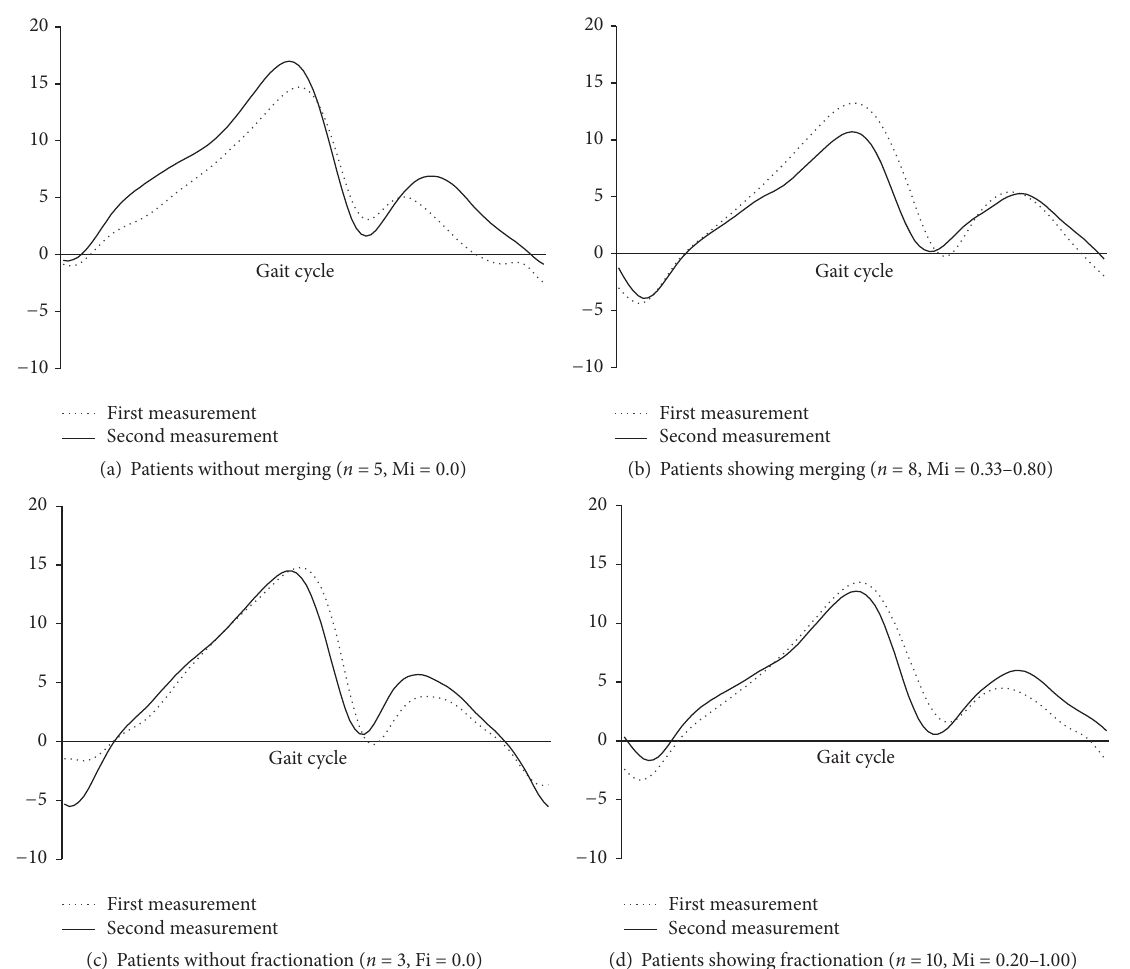
Figure 2: The change of ankle joint angle. The group with merging (b) showed limitation in the range of the ankle joint angle. The patients who did not show merging (a) had the same joint angle range. The group without or with fractionation (c and d) did not show the consistent change of gait